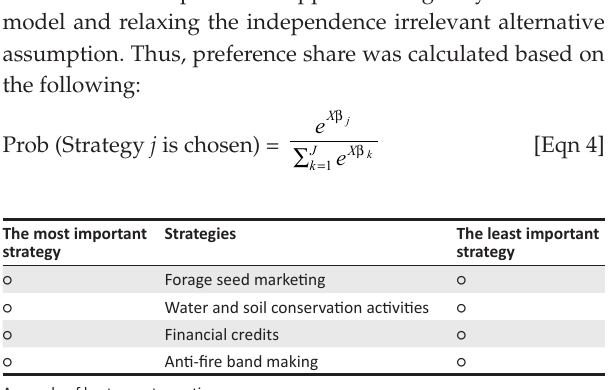
FIGURE 1: Please choose your best and worst strategies to adapt to climate